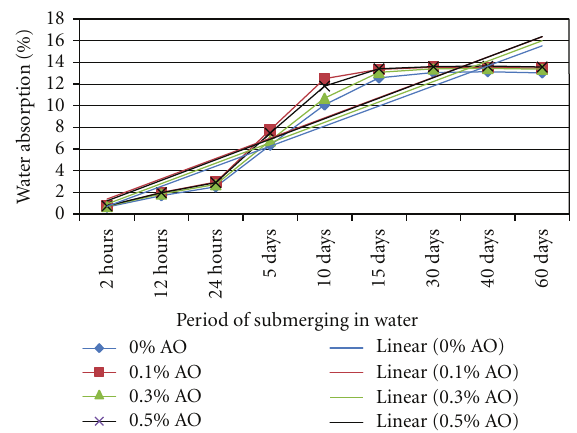
Table 3: Water absorption rate of corotating twin-crew